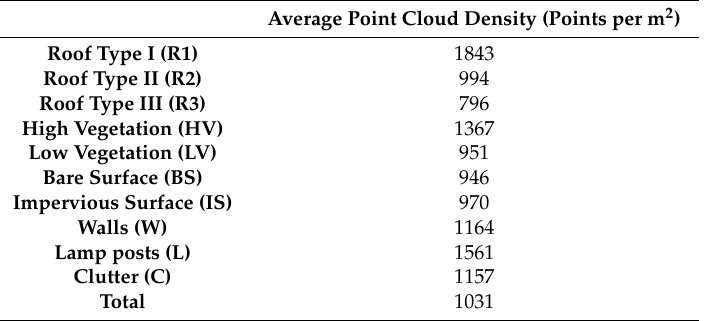
Table 2. Number of labelled pixels and point cloud density for each thematic